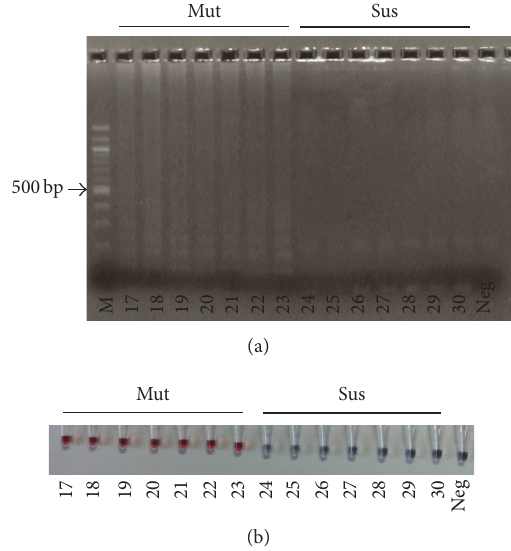
Figure10:Detection ofMDR-TBmembersvia Au-nanoprobeassay. (a) Agarose gel showed LAMP products. Lane 1 (M): Ladder DNA marker; Lanes 17–30: Mut as MDR-TB, Sus as INH susceptible, and Neg as negative. (b) Corresponding results recorded visually after salt challenge. Red colour showed the presence of the target, while purple indicated its